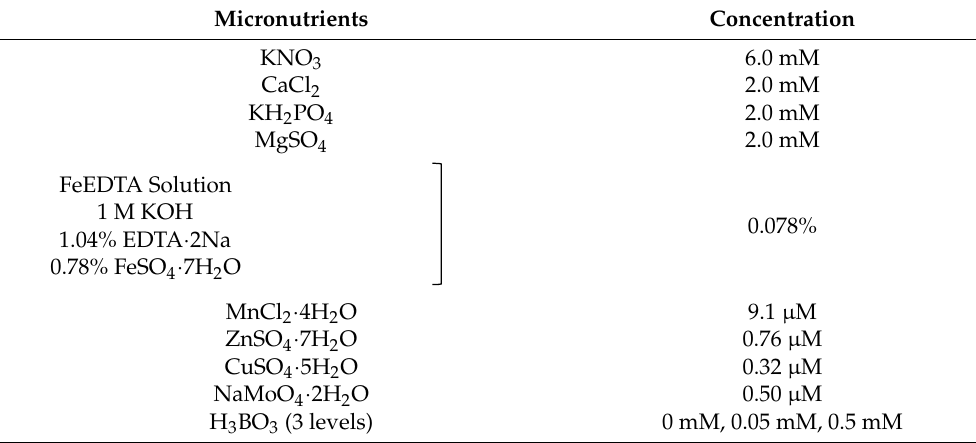
Figure 1. Fresh tissue masses for the load leaf (( A ): leaf two at developmental stage V2 used to administer 11 CO 2 ), the shoots (( B ): including all other leaves and stems), and roots ( C ) are presented here for plants grown under three regimes of boric acid (BA) treatment, including: 0 mM BA, 0.05 mM BA, and 0.5 mM BA. Levels of 0.05 mM BA corresponded to normal levels of boron found in Hoagland’s nutrient (see Table 1). Data bars represent average values ± SE on N = 8–10 replicates. Data was subjected to one-way analysis of variance with a post hoc Tukey’s HSD test to account for multiple comparisons between the different treatment groups (0 mM-to-0.05 mM BA; 0.5 mM-to- 0.05 mM BA; and 0 mM-to-0.5 mM BA). Statistical significance was set at p < 0.05. Table 1. Nutrient Composition.